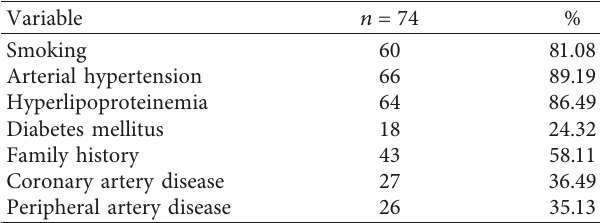
Table 1: Demographic data of the